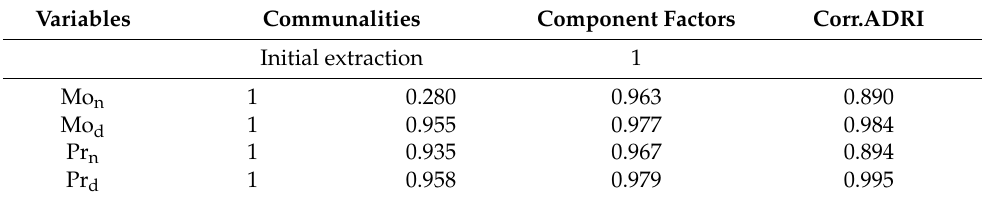
Table 1. Principal component analysis of the agricultural drought resilience index (ADRI). Variables Communalities Component